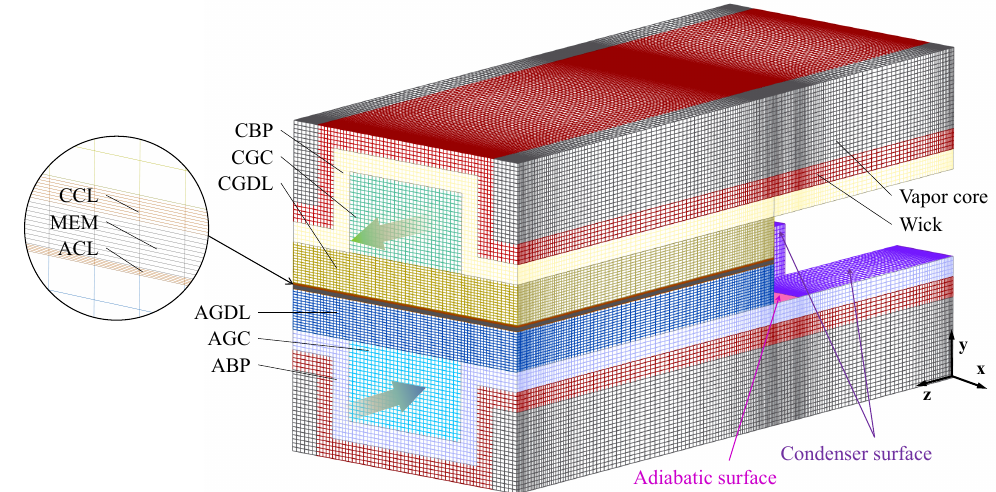
Figure 3. Cross-section of flat heat pipes with different internal